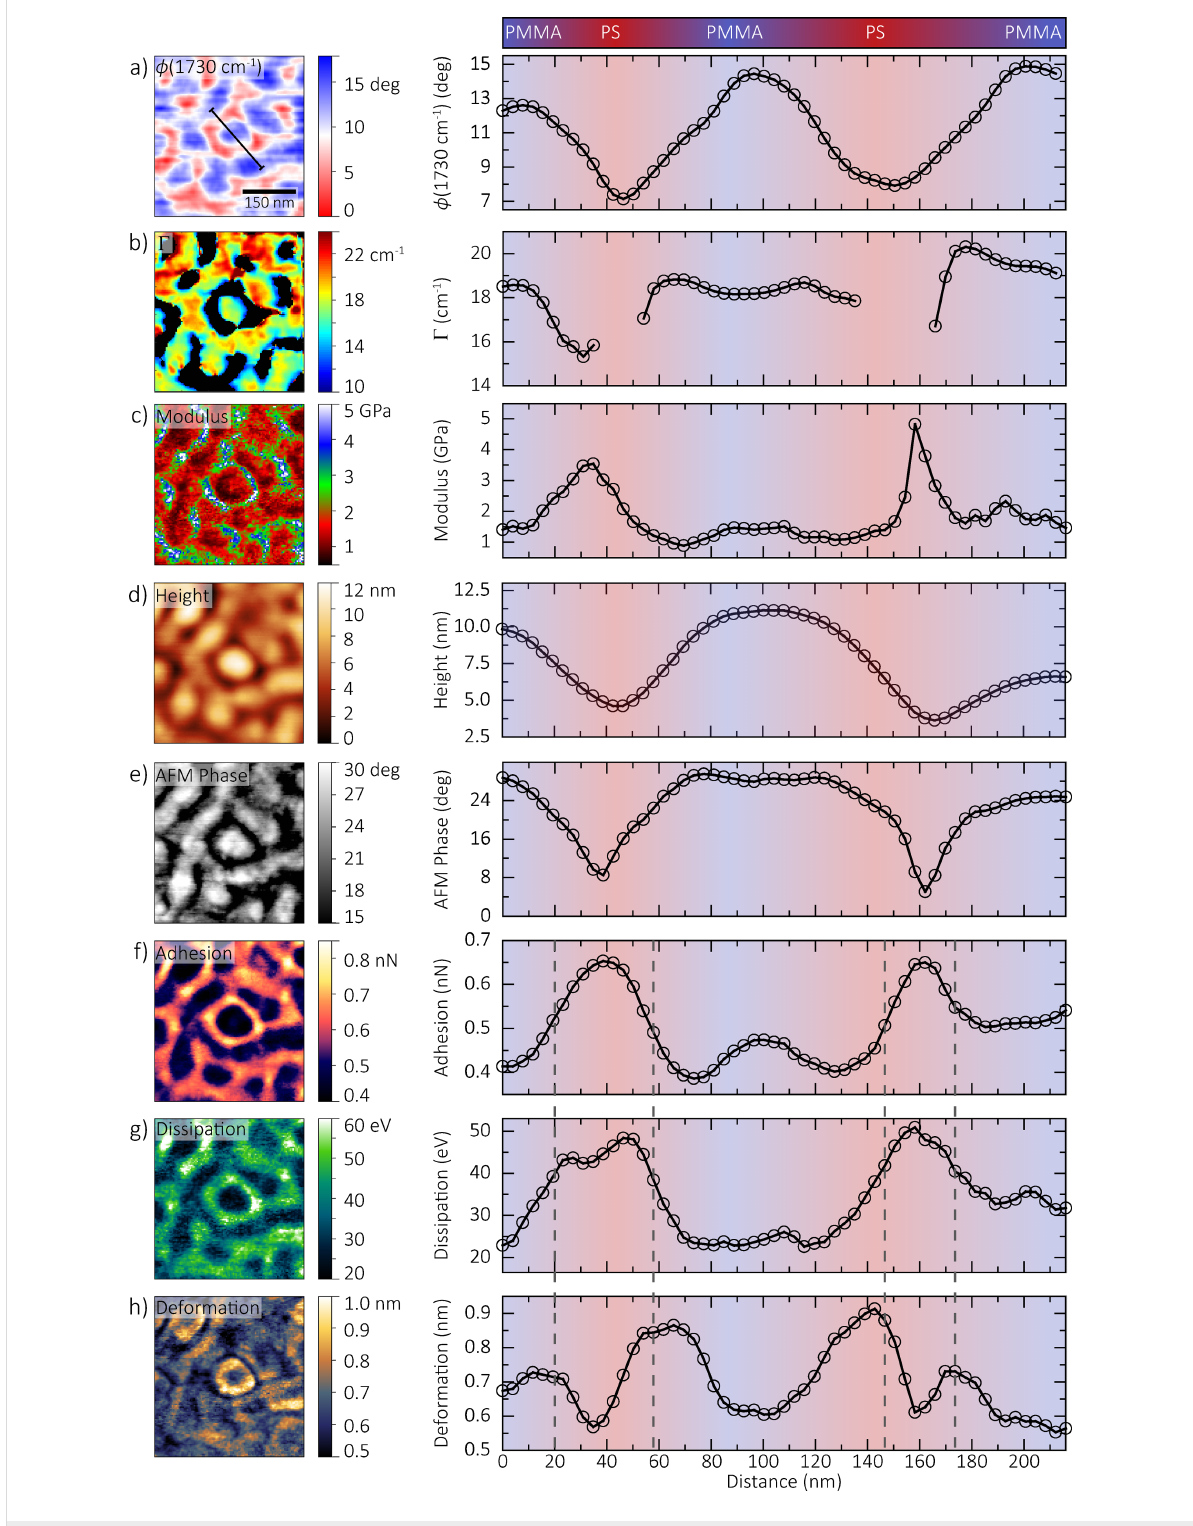
Figure 3: Multidimensional dataset showing maps of PS and PMMA microdomains, with corresponding profiles along the line indicated in (a) aver- aged over a 5-pixel width. Color bar and profile background suggest regions of high PS or PMMA concentration. (a,b,d,e) measured using spatio- spectral s -SNOM and (c,f–h) measured using force–distance spectroscopy. Differences between channels, as highlighted by the dashed lines in (f–h), indicate a complex interplay between crystallinity, composition, and intermolecular interaction between and within single